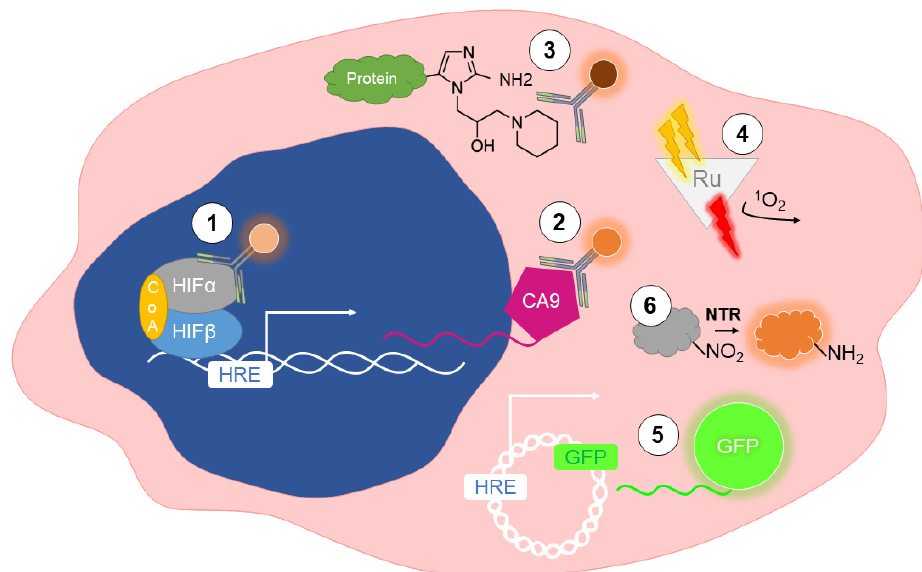
Figure 1. Detecting hypoxia in vitro. ( 1 ) Immunolabeling of HIF-1 α or HIF-2 α protein. ( 2 ) Immunolabeling of downstream transcriptional targets of HIFs (e.g., CA-IX). ( 3 ) Immunolabeling of hypoxia probes delivered exogenously 3 h before fixation (e.g., pimonidazole). ( 4 ) Oxygen quenches phosphorescent probes (e.g., Rubidium) after excitation with 2-photon light. ( 5 ) DNA construct is transcriptionally regulated by HIFs that express any protein (e.g., GFP) in a hypoxia-dependent manner. ( 6 ) Fluorescent molecules activated by nitroreductases (NTR) exclusively under